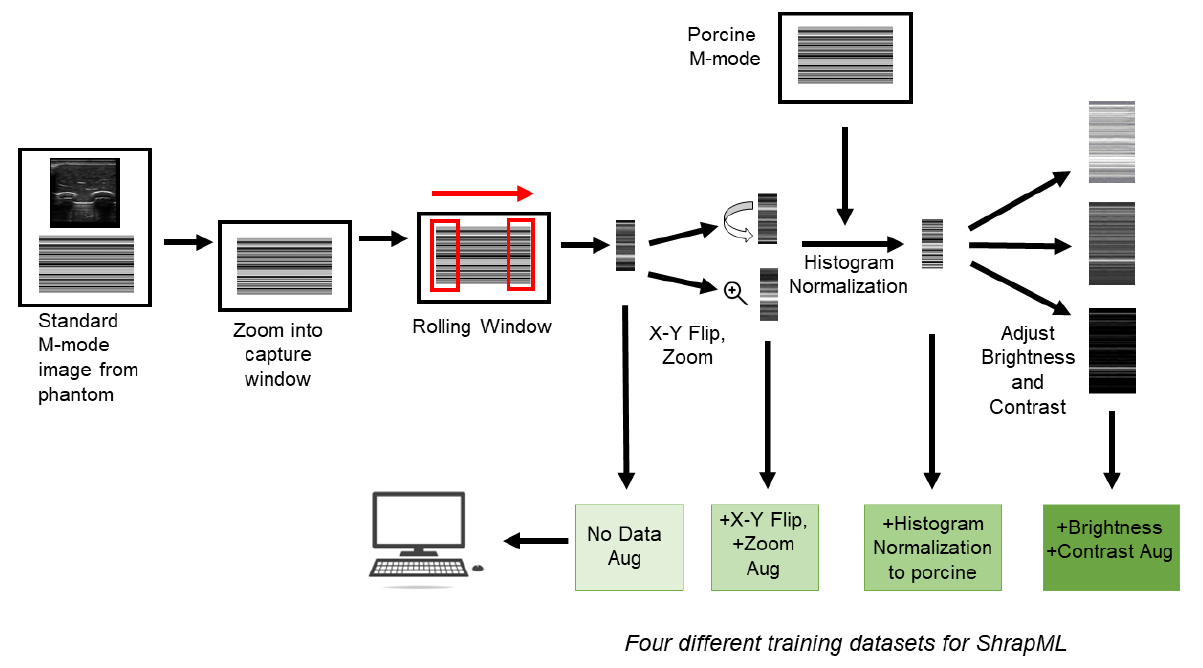
Figure 2. Image processing and algorithm training pathway. M-mode images were obtained from the synthetic phantom, and coordinates of the time capture window were identified. A rolling window method was performed to isolate 100 individual panels from each capture window. The individual panels were used as the initial training set (No Data Aug box). A basic augmentation step was performed to the original dataset to create the second training set (+X-Y Flip, +Zoom Aug box). The third image preprocessing step used a porcine M-mode image to normalize the histogram for the phantom panels (+Histogram Normalization box). The final augmentation step included brightness and contrast augmentation to generate additional images (+Brightness, +Contrast Aug